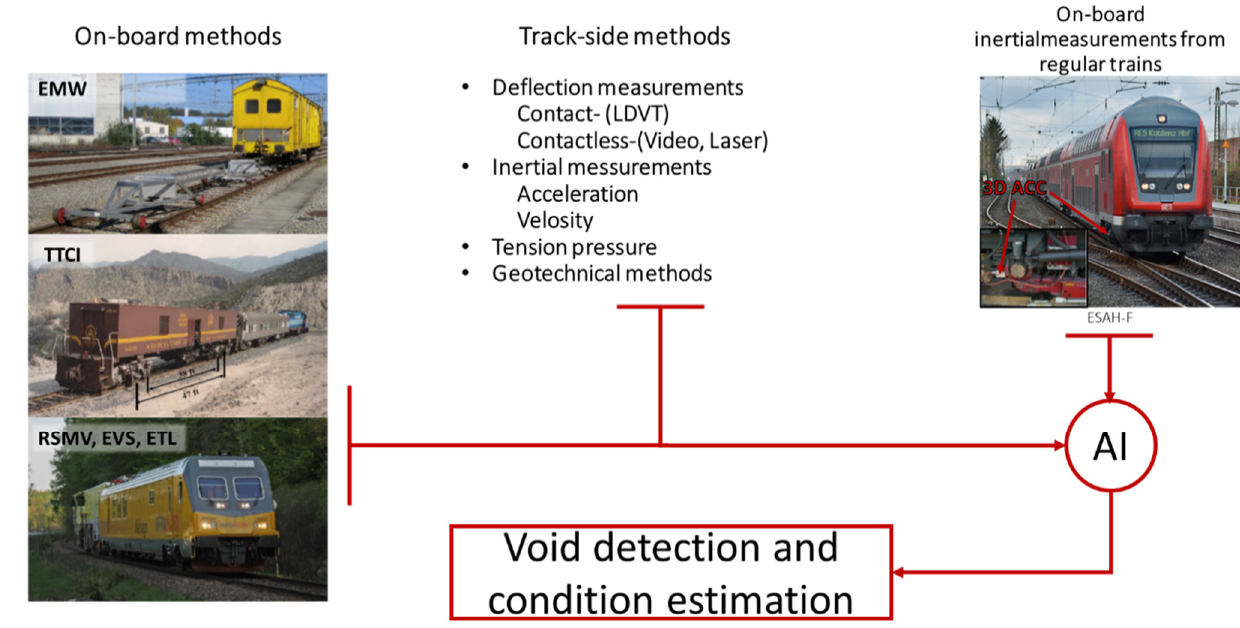
Figure 2. On-board [5–7] and track-side measurement methods for identification of sleeper support condition.